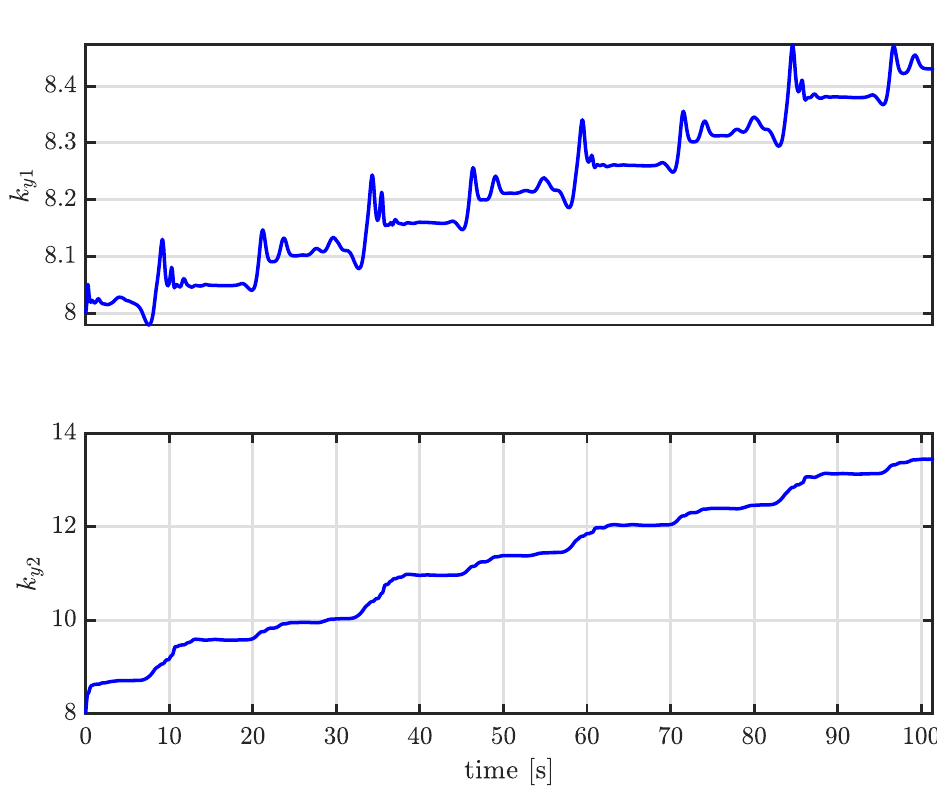
Figure 15. Control gains for yaw control (Case III-experiment).